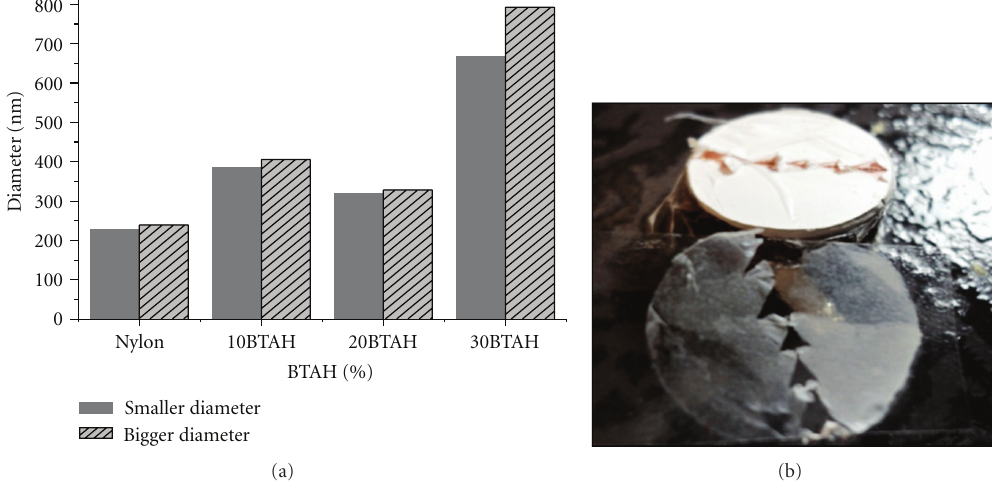
Figure 6: (a) Fiber diameter range as a function of BTAH concentration, and (b) adhesion test for Ny-BTAH 20% copper